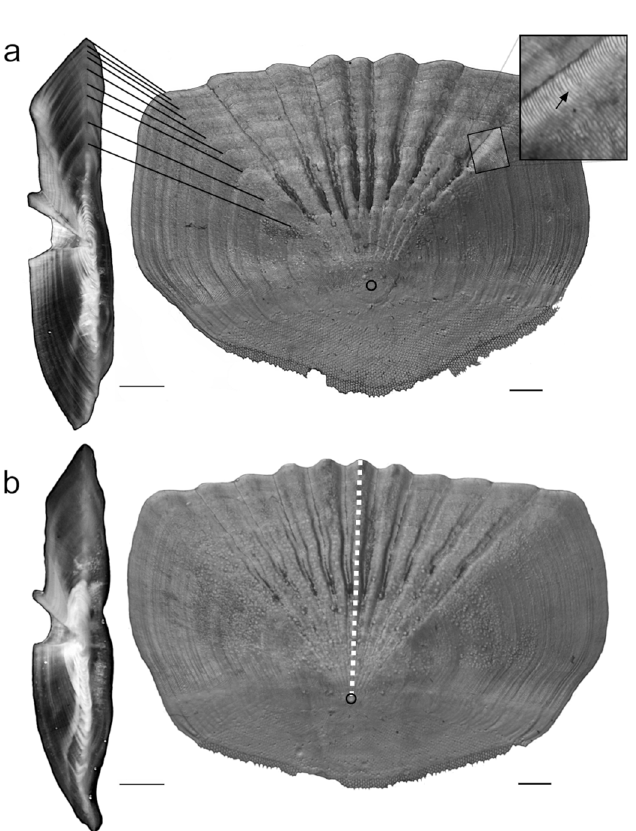
Fig. 2. Otolith section and scales of Pagrus pagrus fi shed along Southern Brazil with “ well-marked ” annuli (a, 9 years old 450mm TL) and faint or absent annuli (b, unaged, 450 mm TL). Scale bar 1mm. Black lines indicate annuli ; black circle indicate the focus; arrow indicate the circuli discontinuity; and the white dashed line indicates the central radius.